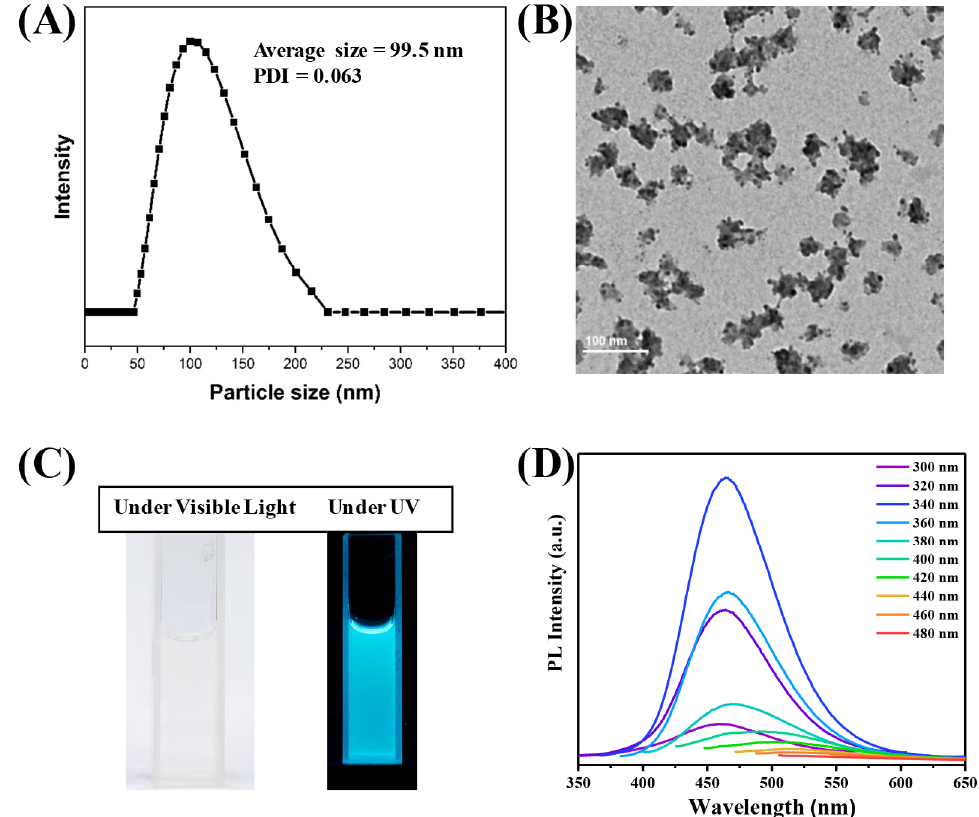
Figure 2. ( A ) Hydrodynamic size and distribution of the nanoparticles measured by the dynamic light scattering in water. ( B ) TEM image of morphology of CDs@PEI nanoparticles. ( C ) Photos of CDs@PEI solutions under visible and UV lights (irradiation with 365 nm UV light). ( D ) Photoluminescence spectra of CDs@PEI nanoparticles under excitation wavelengths from 300 nm to 480 nm.